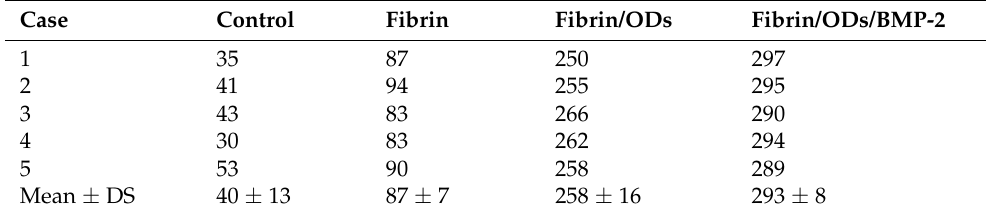
Table 3. The ratio of the volume of formed dentin to the total volume.